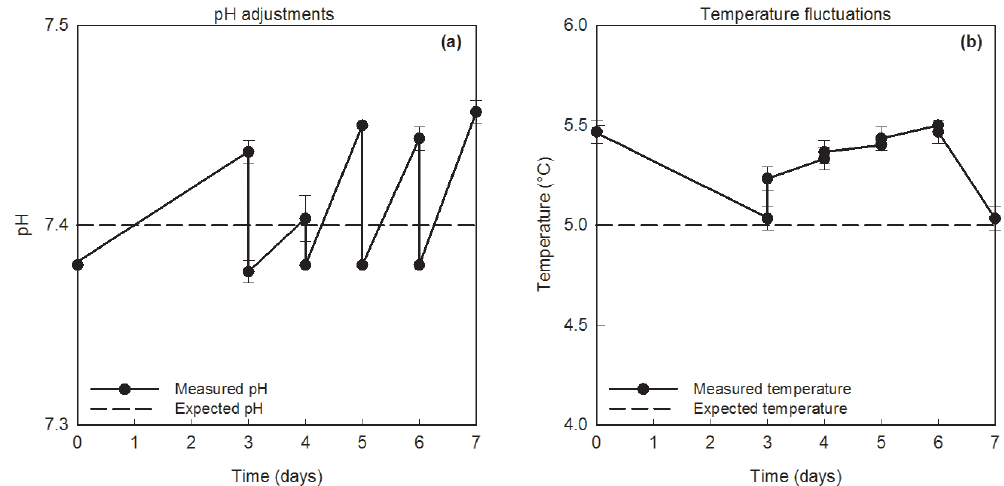
Figure 3. (a) An example of pH adjustments in the pH treatment 7.4 at 5 ◦ C, shown as a function of time. (b) An example of temperature fluctuations in the treatment with pH 7.4, shown as a function of time. The first 3days represent the acclimation period and are not included in the results. Error bars represent ±